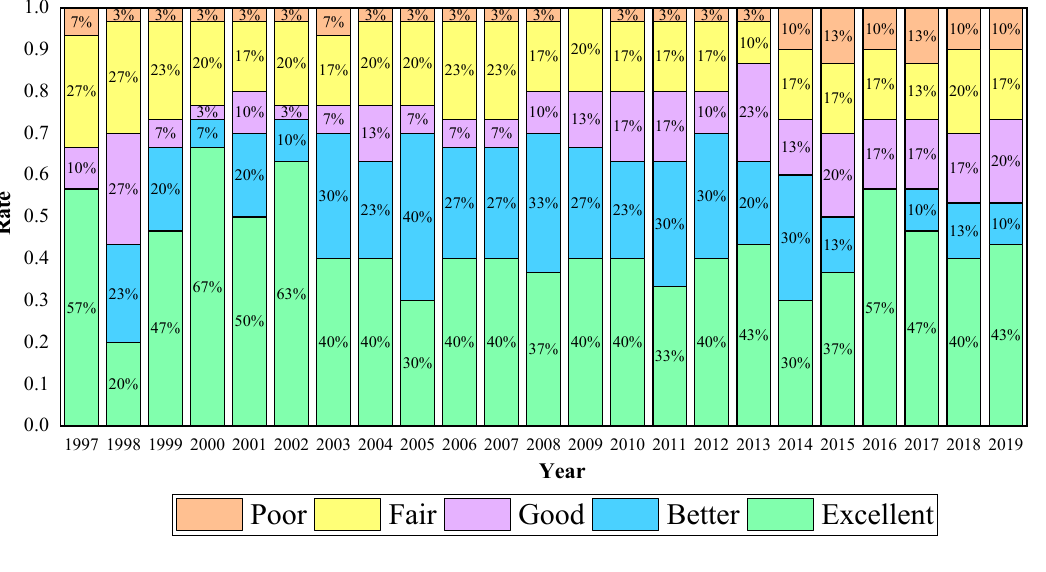
Figure 8. Proportions in each classification of EWP efficiency from 1997 to 2019.